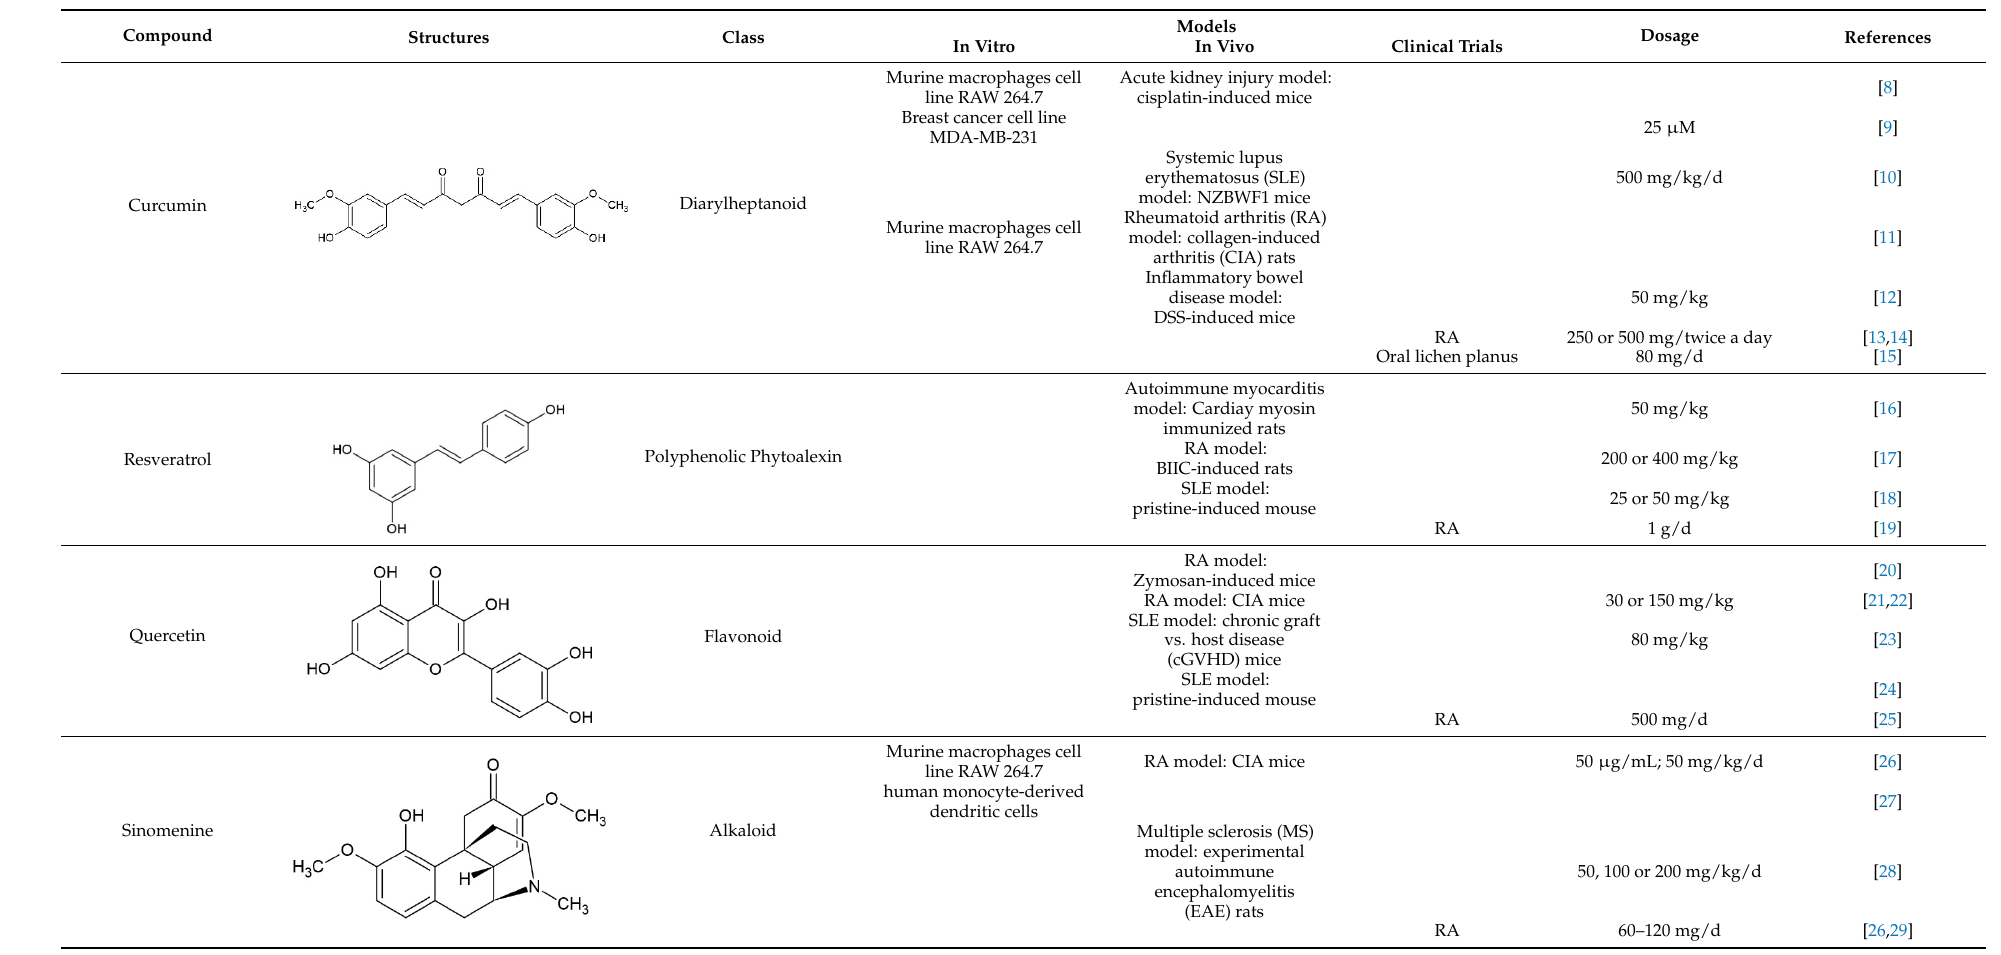
Table 1. Natural products tested in animal models and in clinical trials of autoimmune diseases.